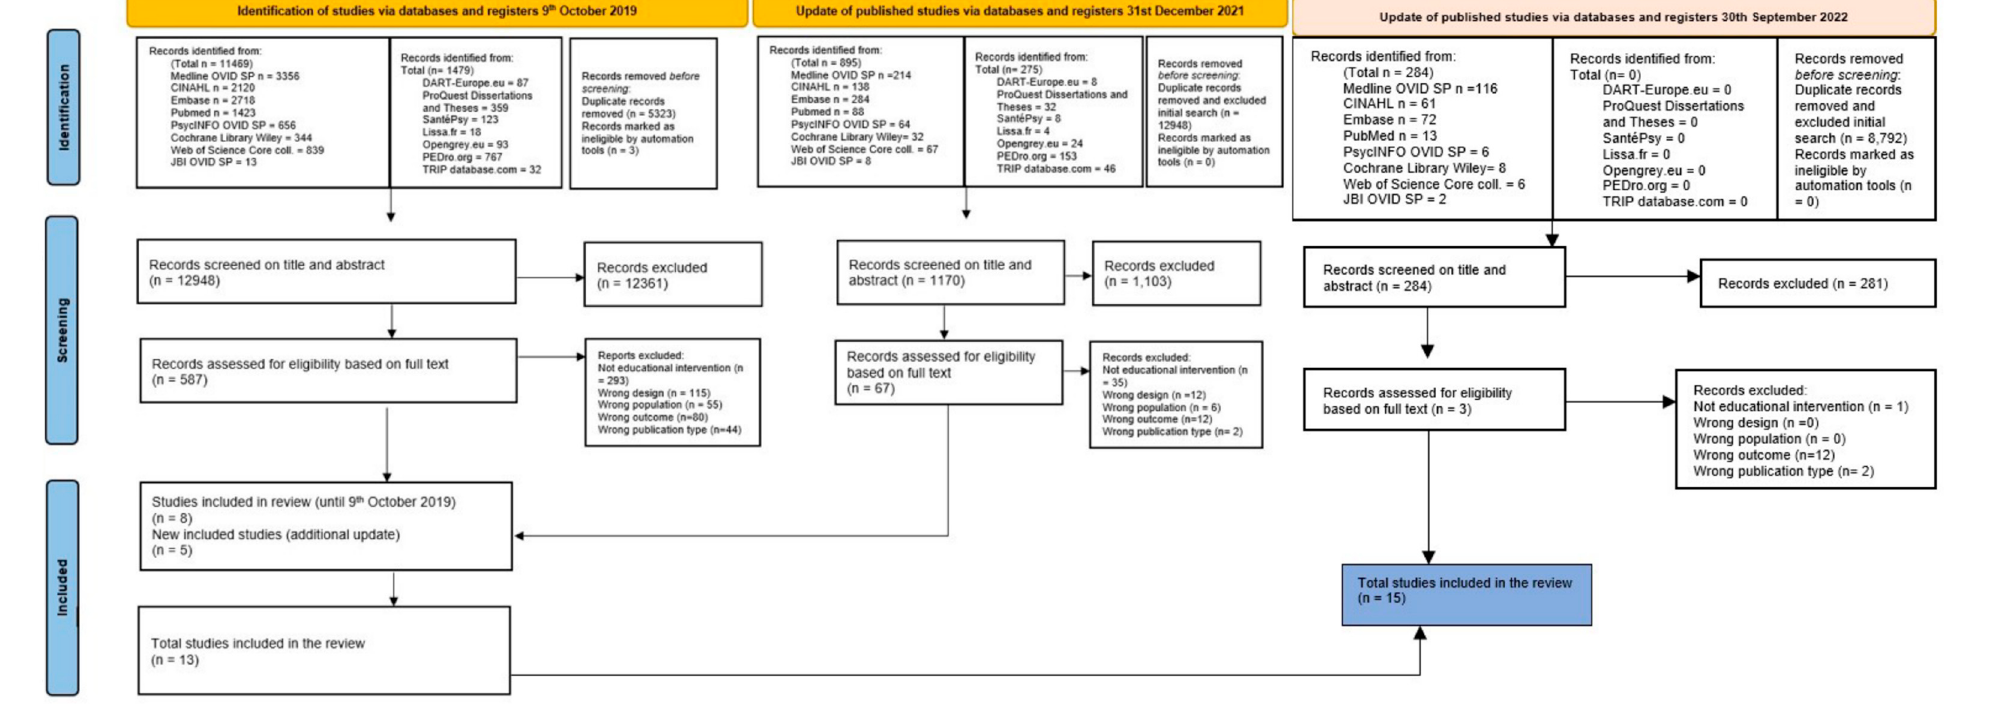
Figure 1. Search strategy for the EDITcare systematic review [46].